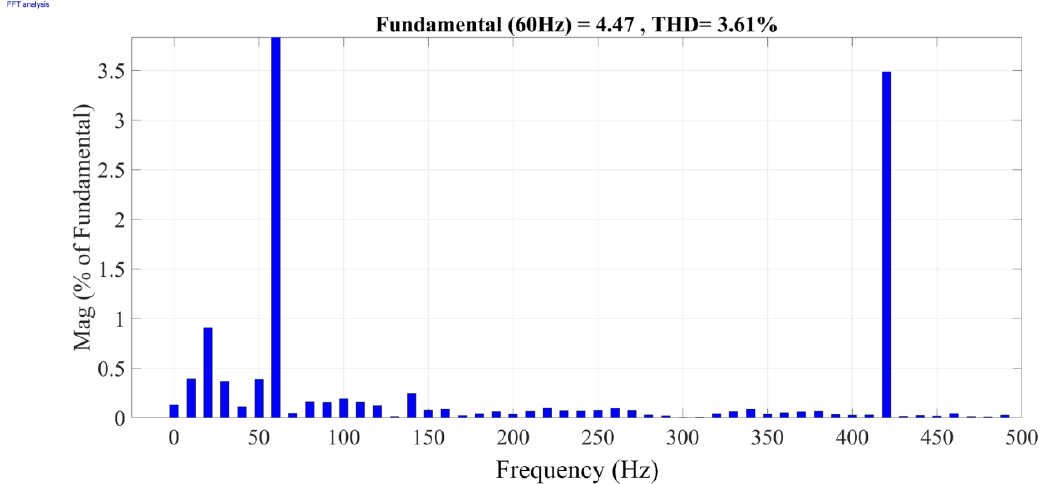
Figure 18. Bar chart with 7th order harmonic on current at high voltage of TUT. Vertical axis: 10%/div. Horizontal axis: 100 Hz/div.